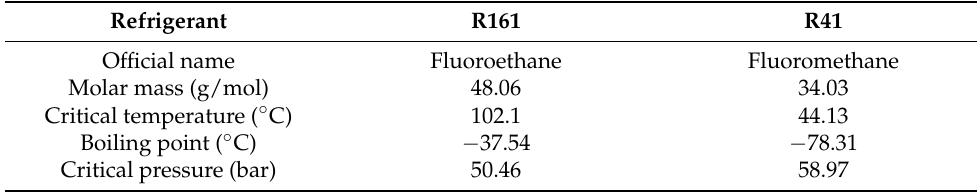
Table 1. Main properties of the refrigerants considered in this research [34].